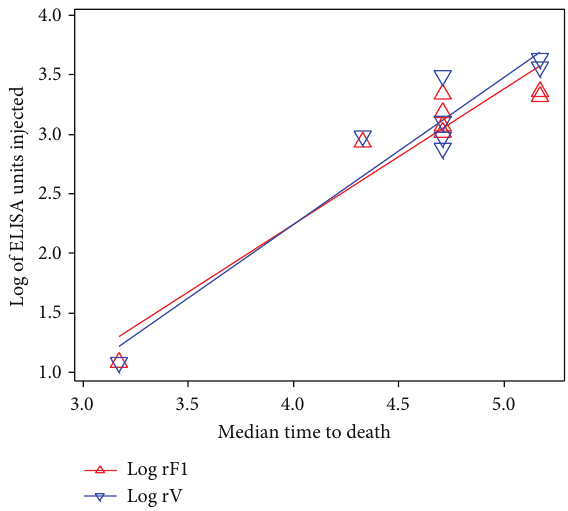
Figure 5: When all of the passive protection data from BALB/c mice were pooled, the log ELISA titre against both rF1 and rV correlated with survival time.